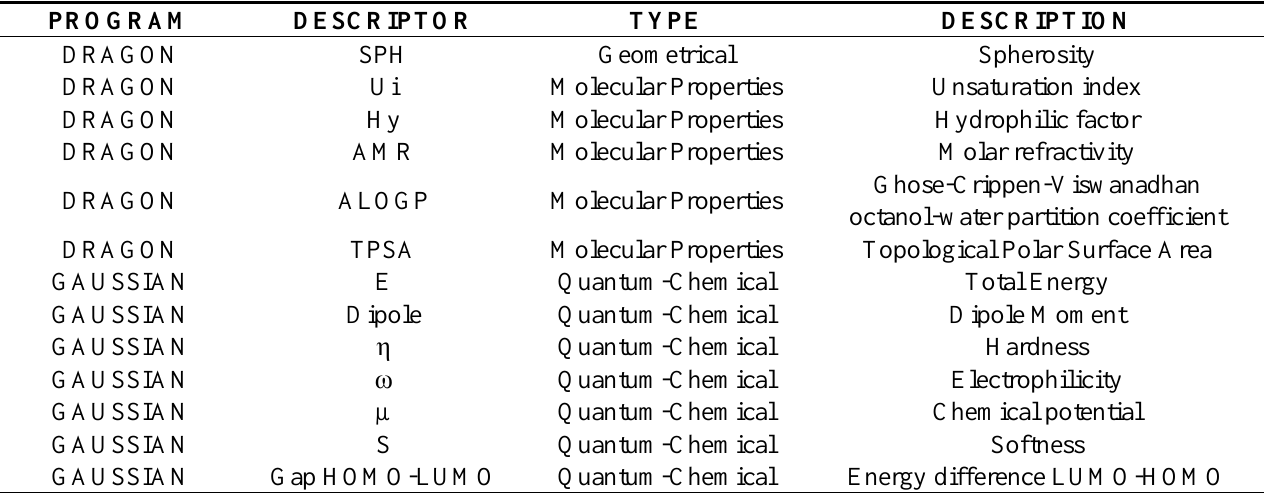
Table 2. Descriptors used in our